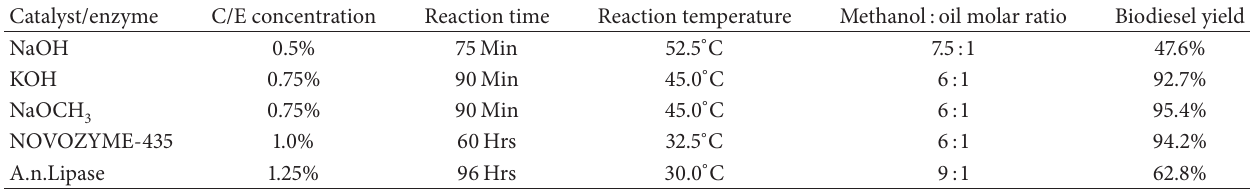
Table 2: Optimized reaction parameters for biodiesel production using chemical and enzymatic transesterification of under-study feedstock.